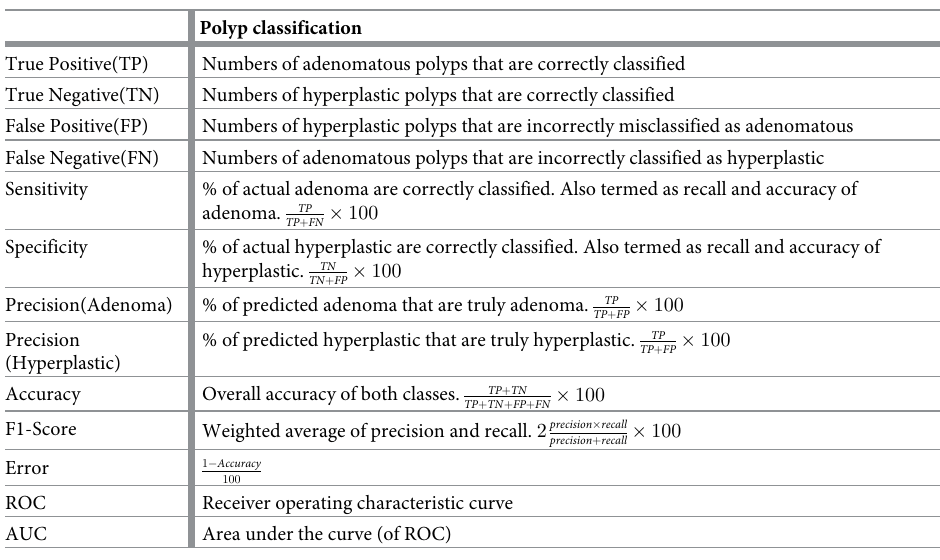
Table 2. Evaluation metrics.